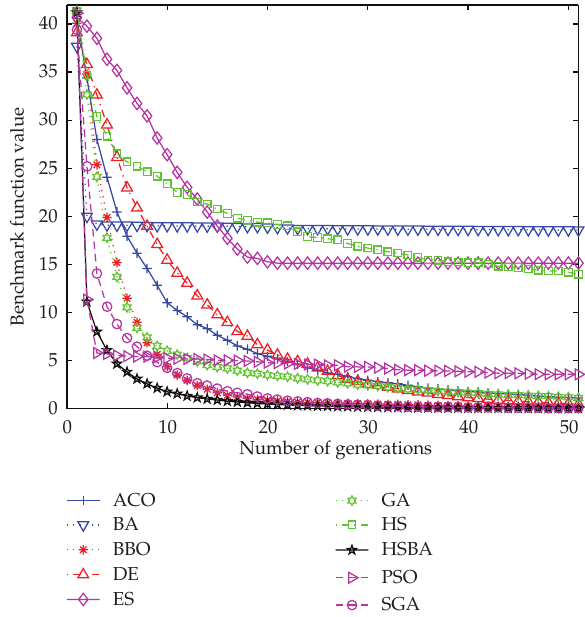
Figure 4: Comparison of the performance of the different methods for the F04 Penalty #1 function.